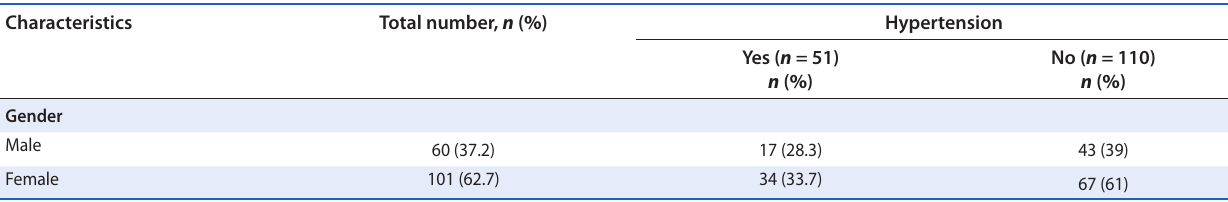
Table 1: Description of the demographic characteristics of the Kang participants, Botswana, in 2008 Characteristics